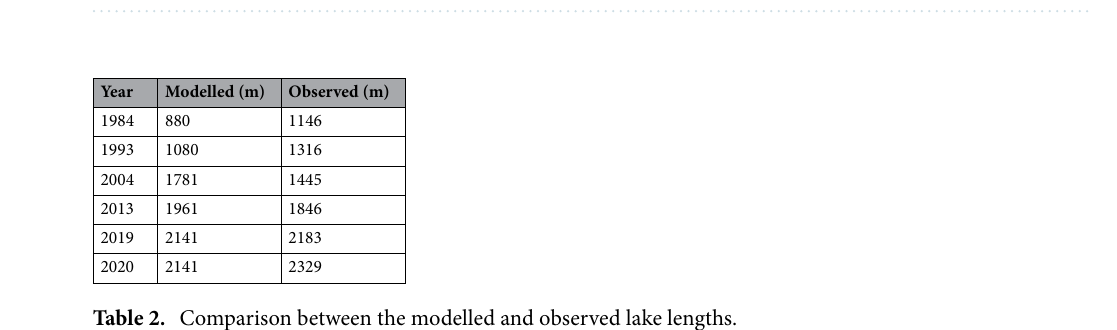
Figure 7. Lake length fluctuations RMSE between observed and modelled lake lengths ~ 110 m with maximum and minimum deviation of 173 m and 20 m respectively. (URL: www. mathw orks. com).